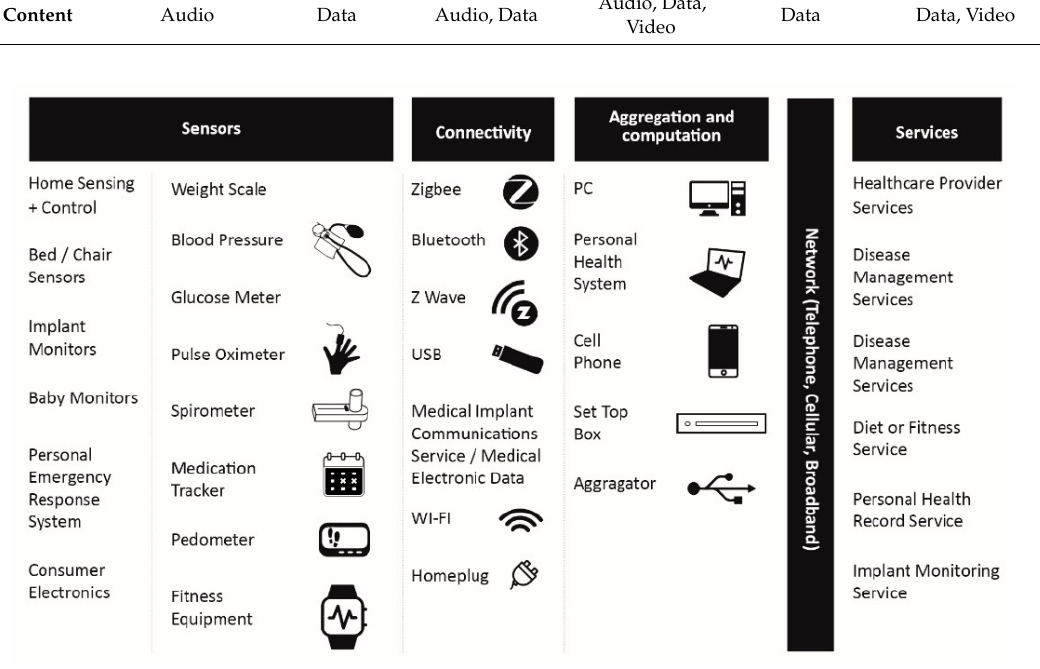
Figure 7. Continua personal eHealth ecosystem. (Adapted from Carroll et al . [52]).